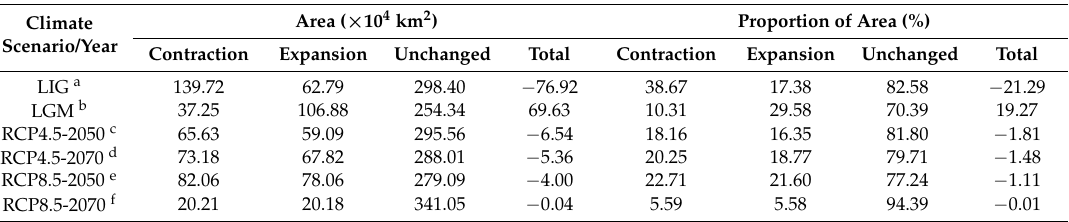
Table 2. Dynamic changes in the suitable area for Salicaceae plants under different combination of climate